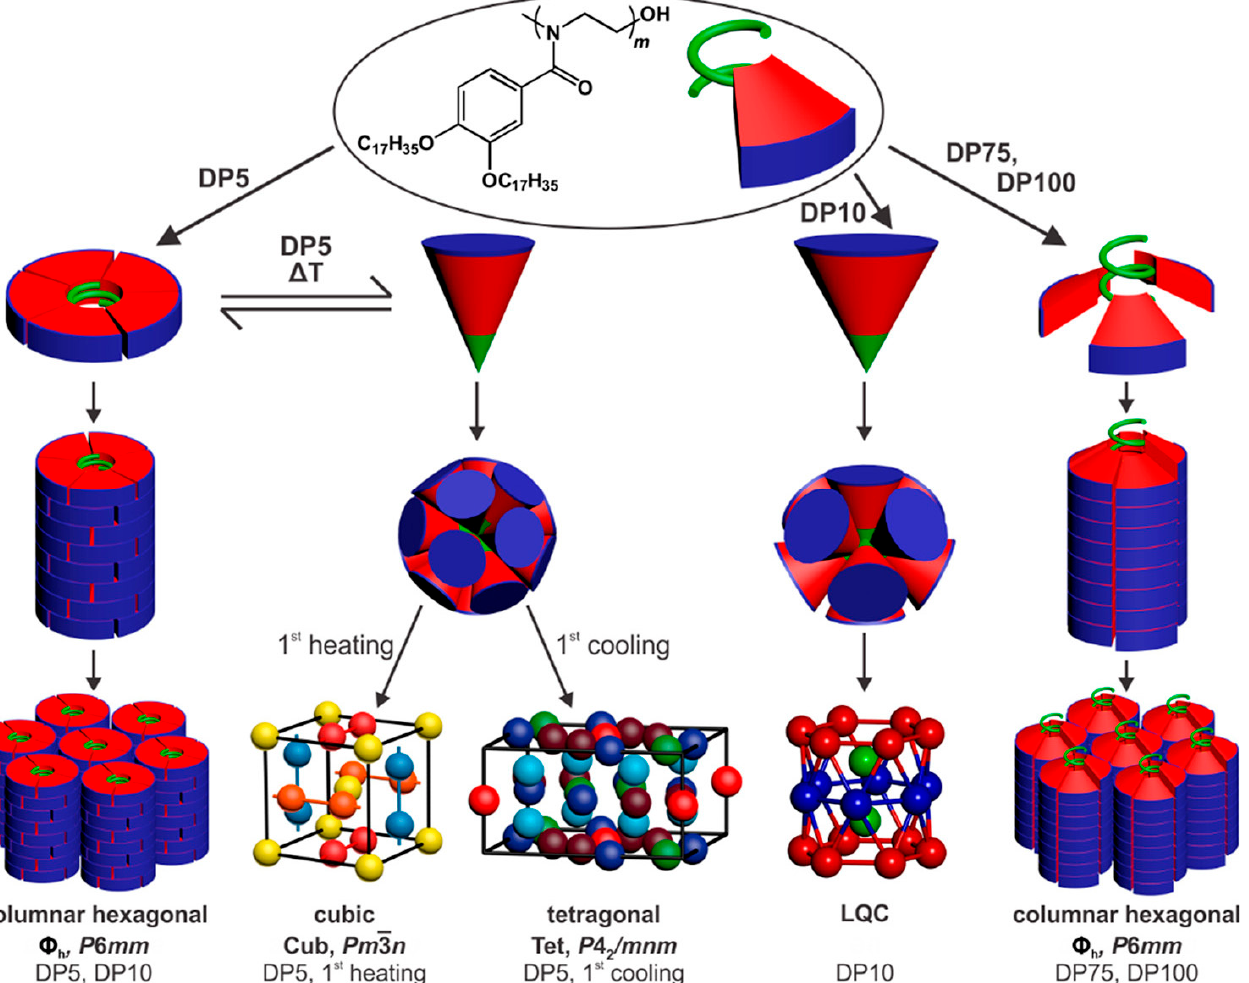
Figure 16. Summary of periodic and quasiperiodic arrays self-organized from assemblies of poly[(3,4)17G1-Oxz] at different degrees of polymerization (DP) and temperature [144]. This Figure is reproduced with permission from [144]. Copyright © 2018, American Chemical